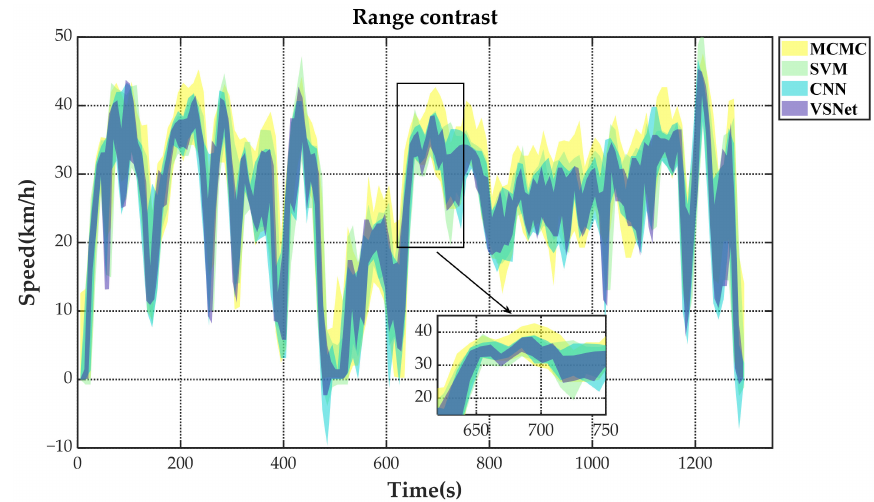
Figure 10. The distribution ranges of the predicted tails of the four methods.